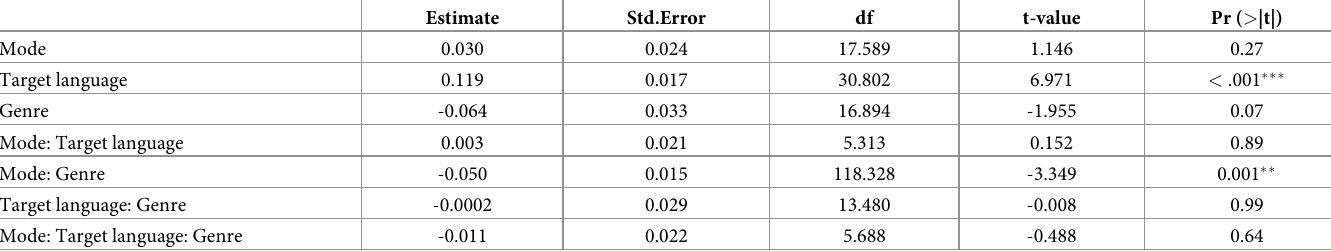
Table 6. Model results for attention shift between ST and TT